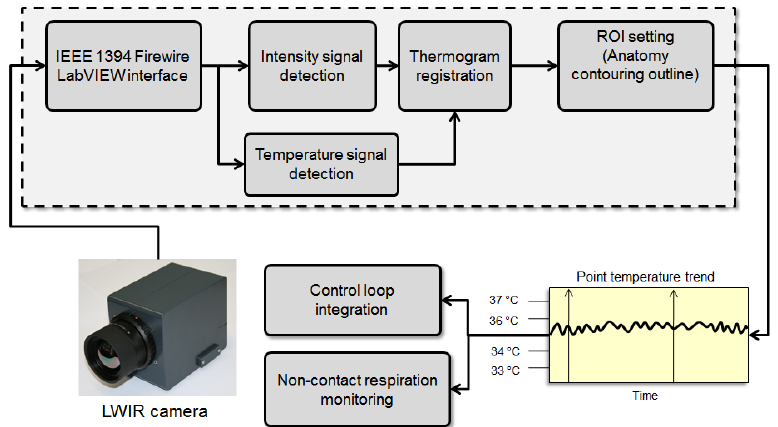
Figure 9. Block diagram of Long wave (LWIR)/middle wave infrared (MWIR) and short wave infrared (SWIR) thermography processing in a computer-aided diagnosis system.